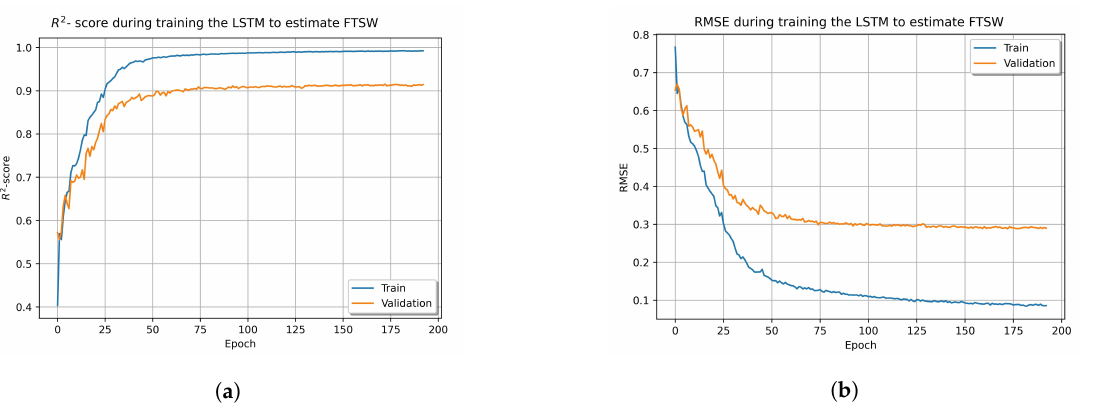
Figure 8. ( a ) R 2 -score and ( b ) RMSE during training of the BiLSTM model with an output length of seven days, seven days of look-back, and the VPD as the input to the